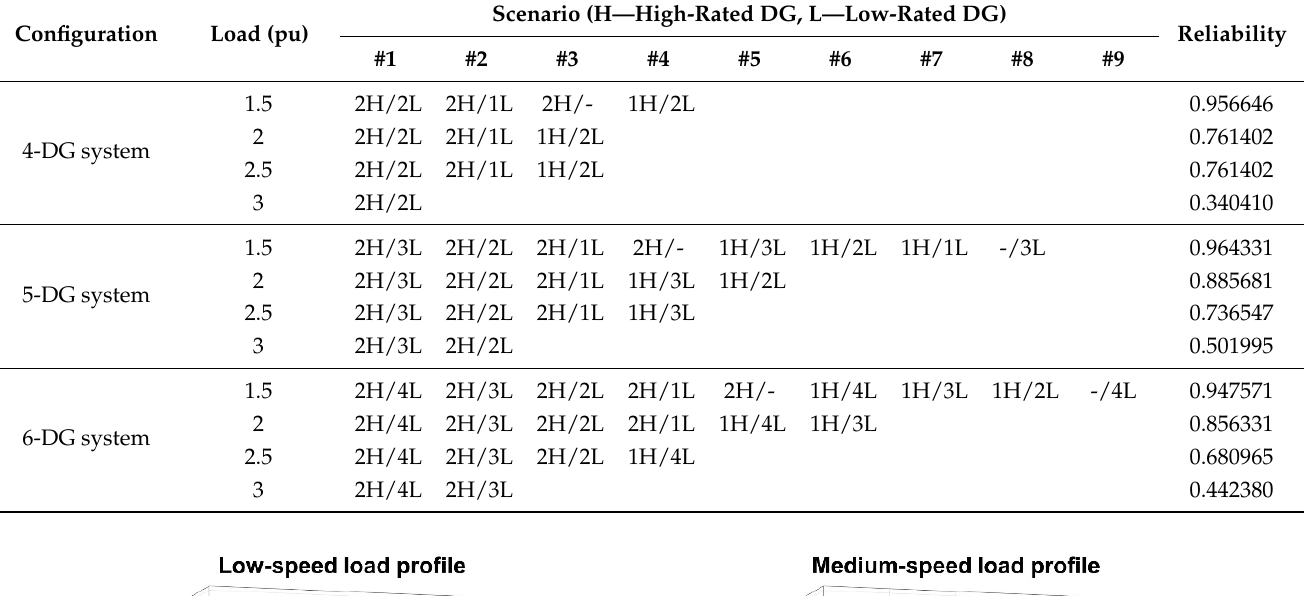
Table 5. Reliability for weighted k -out-of- n redundancy systems.